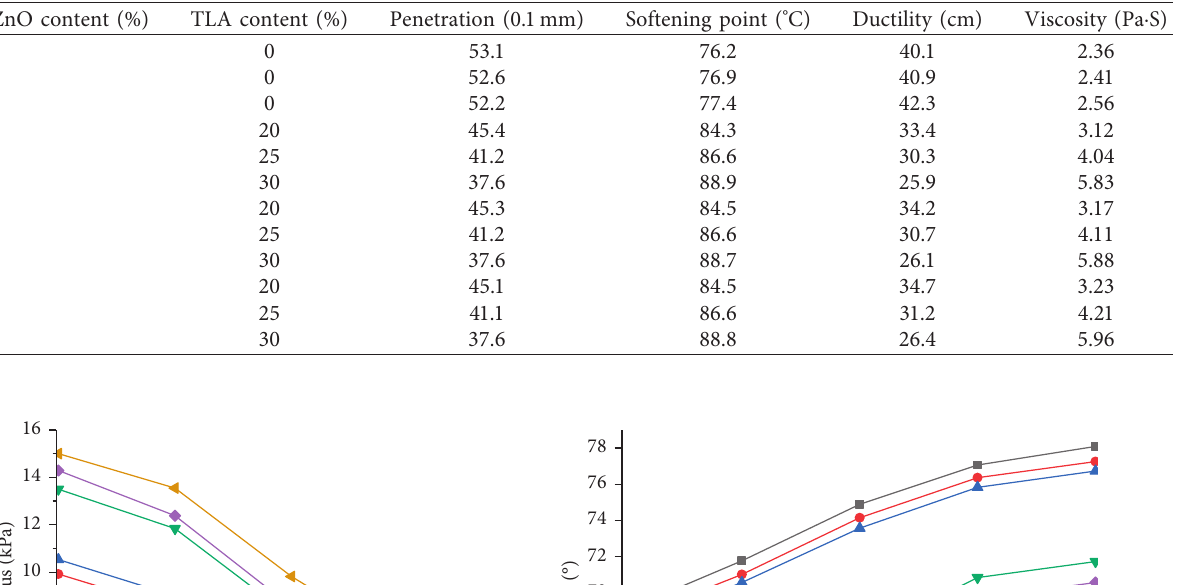
Table 2: Test results of basic performance of SBS asphalt under different modifier content.